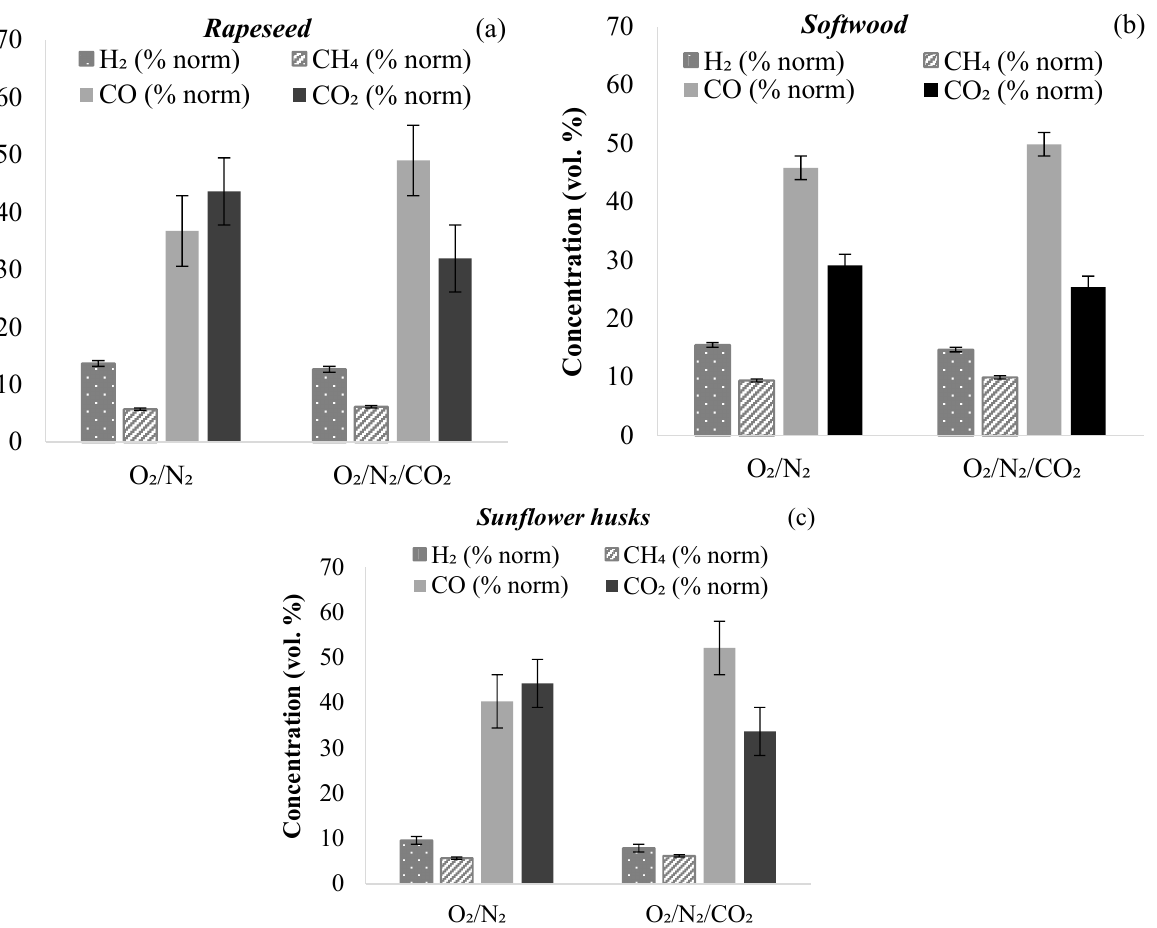
Figure 2. Effect of biomass and gasifying agent on syngas composition during gasification of ( a ) rapeseed, ( b ) softwood, and ( c ) sunflower husks in a drop tube furnace (DTF), at 1000 °C.